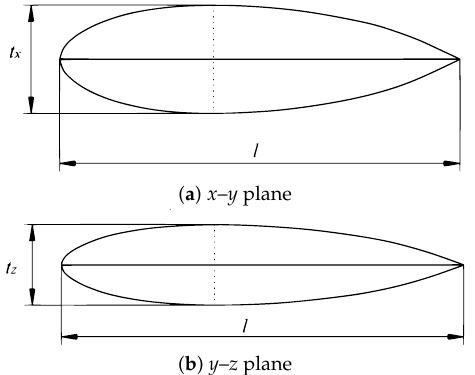
Figure 5. Parametric curves in two planes. Proposed by the authors based on the leatherback turtle’s geometry